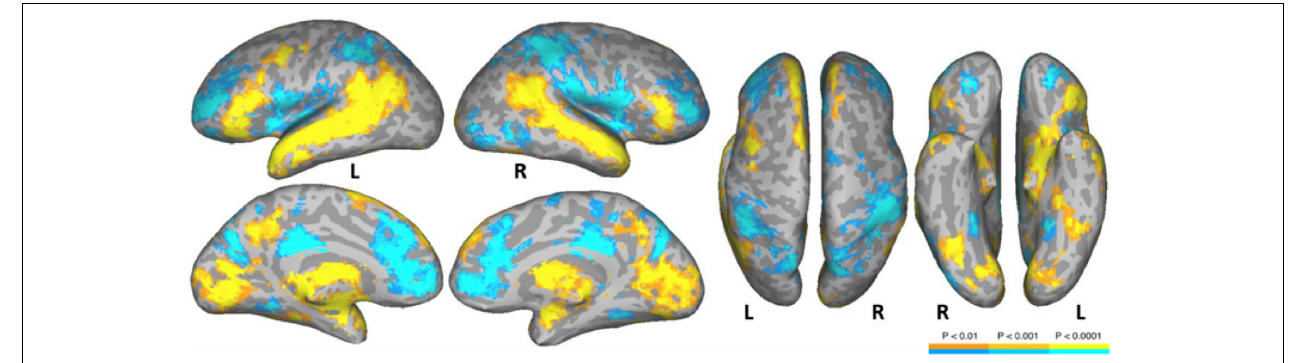
FIGURE 3 | Areas activated in a whole-brain analysis of the contrast of natural text reading (NT) versus the average of pseudowords and consonant strings (mean of PW and CS). Hot